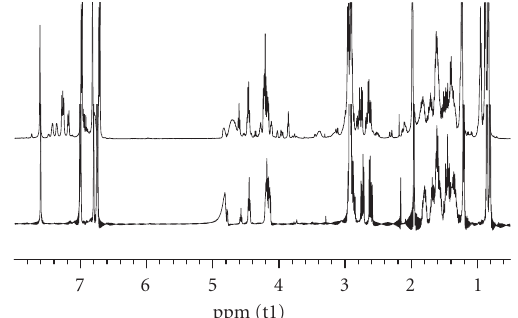
Figure 5: 1 H-NMR spectra (overlaid) of the free peptide (bottom) and of the Ni(II)-peptide solution (1 : 2) in D 2 O at pH ∗ =